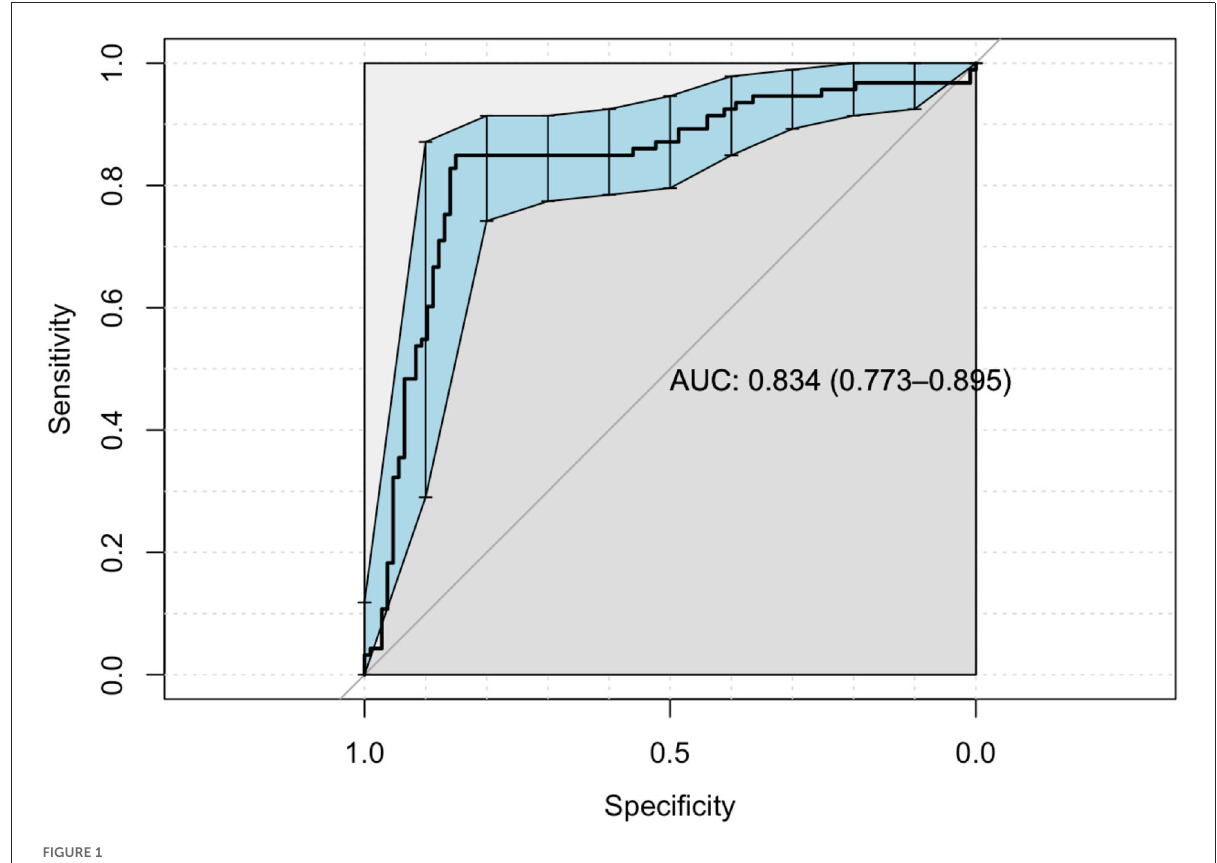
FIGURE1 ROC for